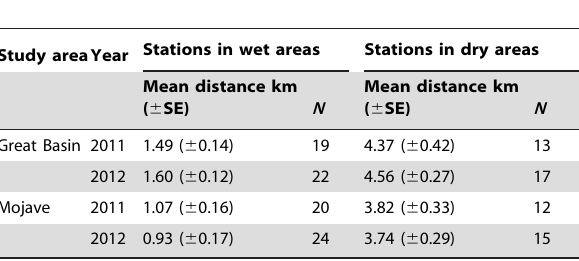
Table 1. Distances from scent stations to nearest known source of free water in wet and dry areas, 2011 to 2012.